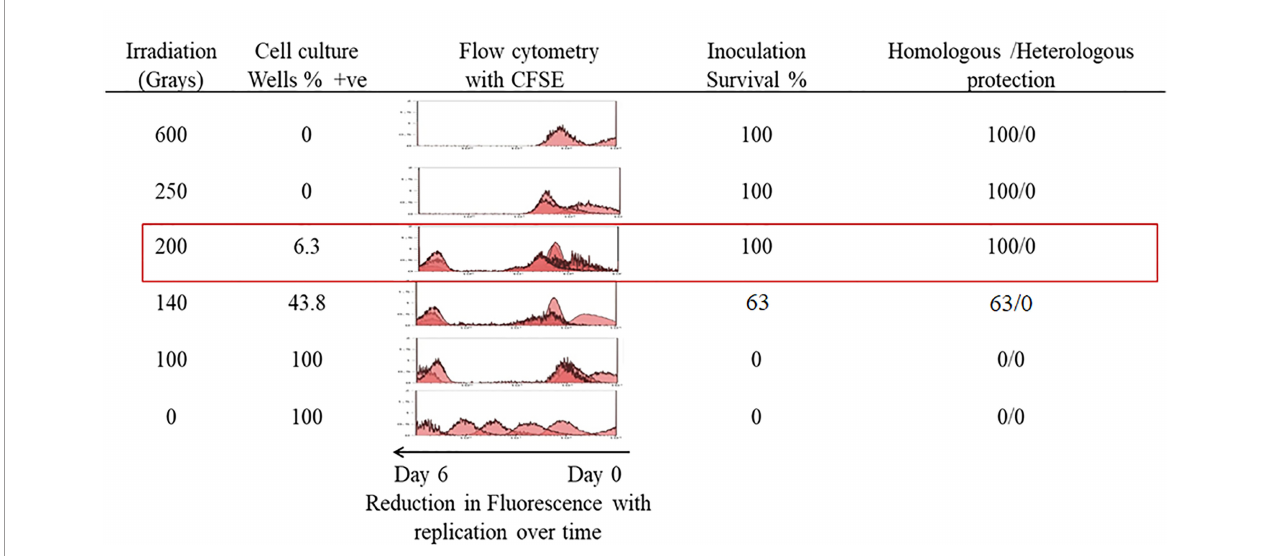
FIGURE 1 | In-vitro growth analysis of irradiated parasites. Parasites irradiated at different doses were observed over a 7-day period post-irradiation and 200Gy was identi fi ed as the maximum dose applicable. Percentage survival was calculated from the number of wells containing parasites that survived in a 24 well plate. A parallel plate was used to measure replication of parasites labelled with CFSE, which halves in concentration with each doubling of parasites. Eight female BALB/c mice per group were each inoculated with 1 x 10 4 parasites irradiated with doses ranging from 600Gy to 100Gy and a control group received 1 x 10 4 non-irradiated parasites. Surviving mice were further challenged with 1 x 10 3 of either homologous T. evansi RoTat 1.2 or heterologous Can 86K